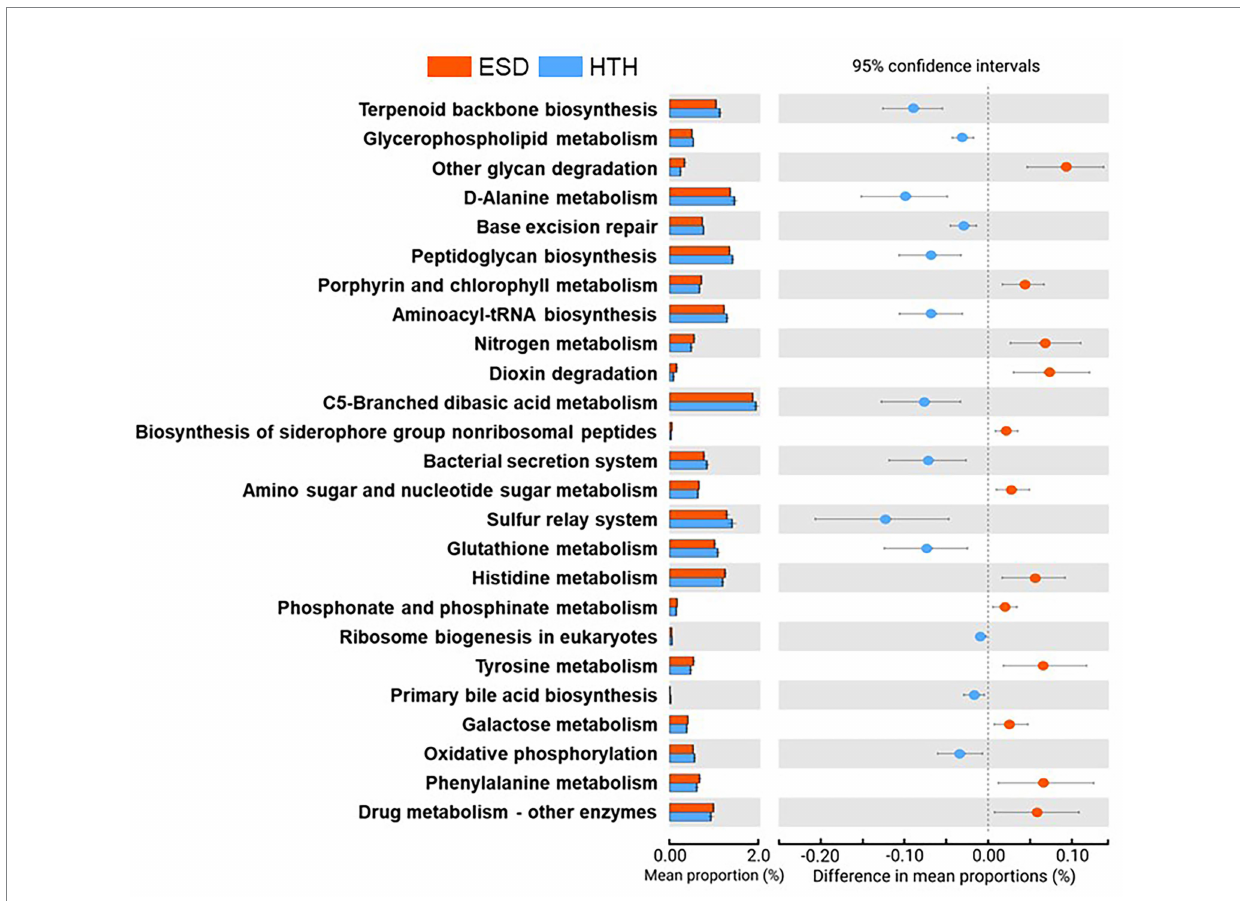
FIGURE 4 Functions of carapace microbiota. Extended error bar plot indicates 25 KEGG orthology gene families that were significantly different between ESD and HTH (White’s non-parametric t -test, two-sided, p ≤